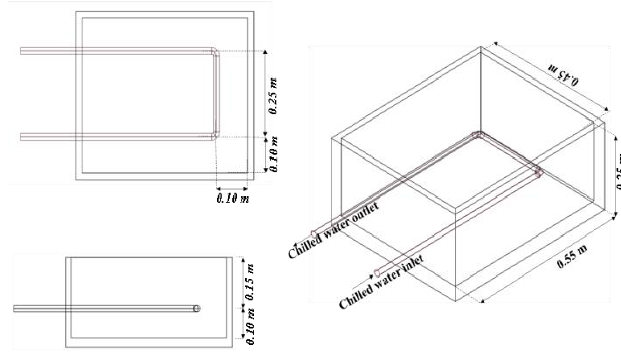
Figure 5 : Schematics of the experimental soil bed and piping configuration